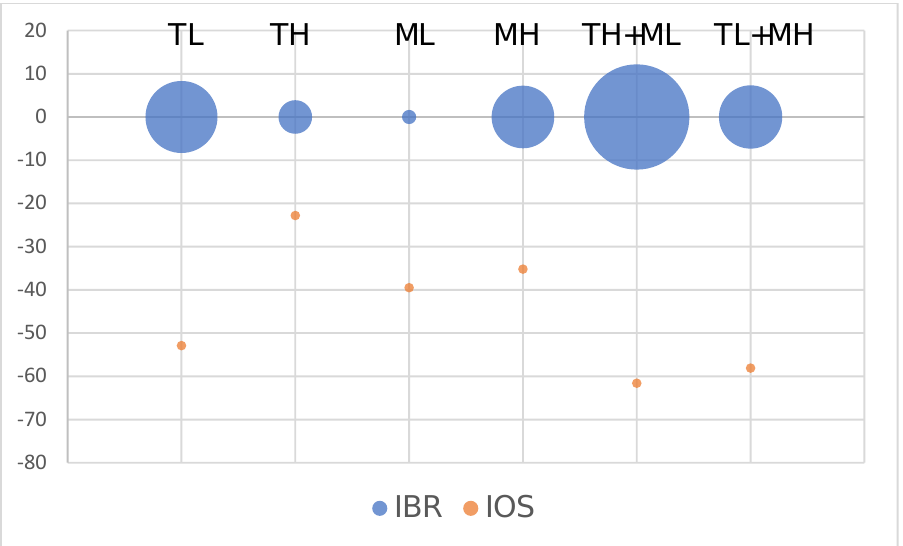
Figure 6. Integrative oxidative stress response and biomarker response in zebrafish after the effects of terbuthylazine (2 µg L -1 (TL) and 30 µg L -1 (TH)) and malathion (5 µg L -1 (ML) and 50 µg L -1 (MH)). IBR- integrative index of biomarker response, IOS – integrative index of oxidative stress.